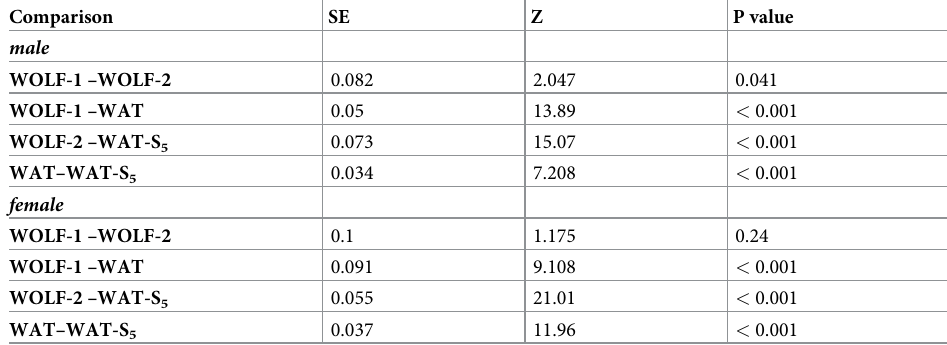
Table 4. Results of pairwise ratio tests comparing LC 50 s among strains of D . suzukii